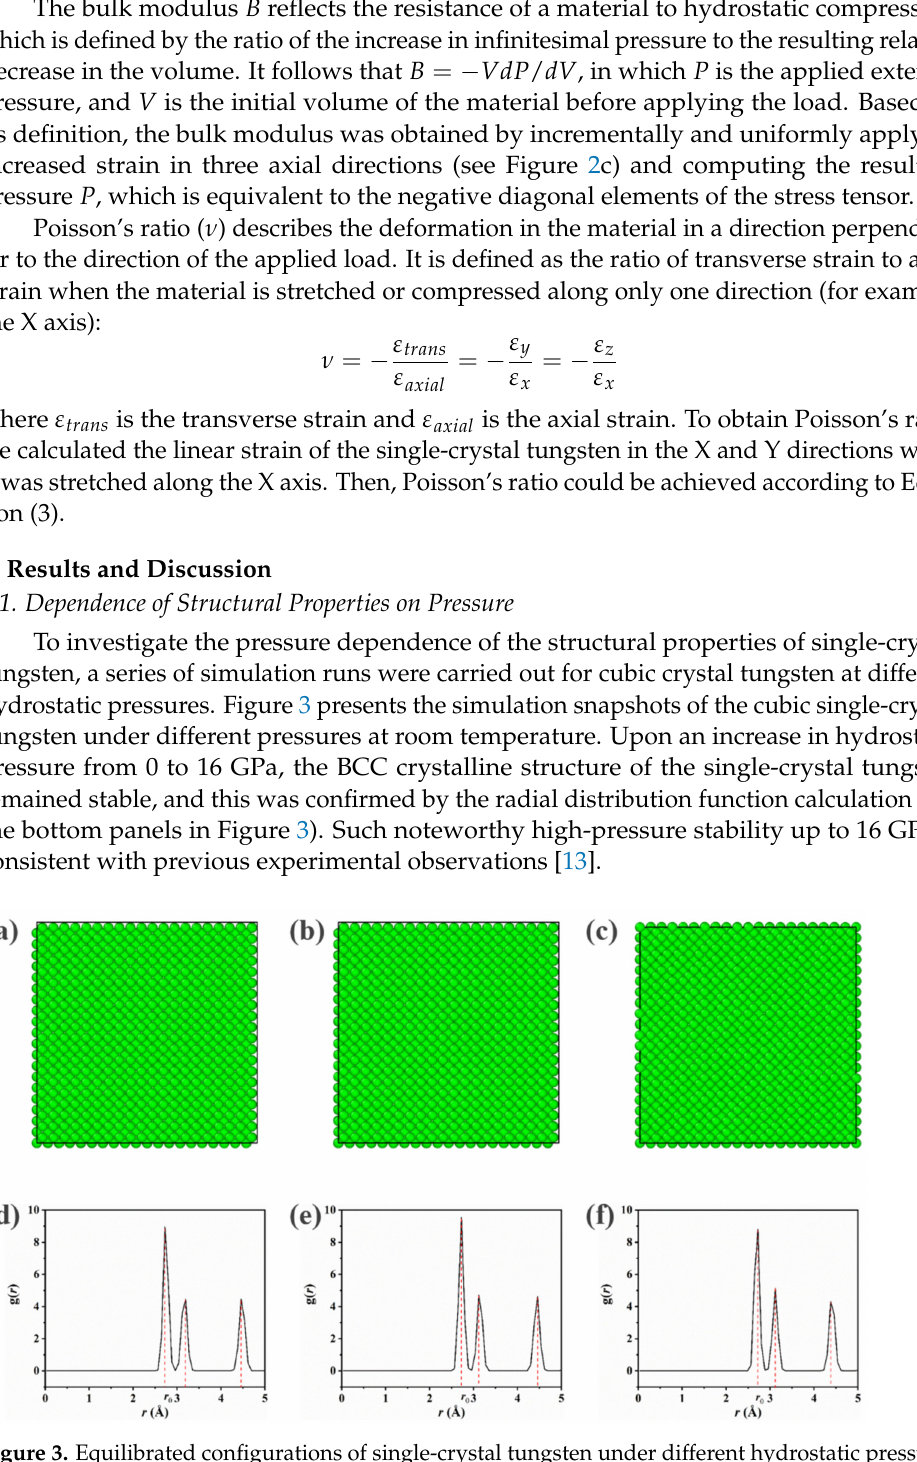
Figure 3. Equilibrated configurations of single-crystal tungsten under different hydrostatic pressures: ( a ) 0 GPa, ( b ) 8 GPa, and ( c ) 16 GPa. The corresponding radial distribution functions of single-crystal tungsten under different hydrostatic pressures: (d) 0 GPa, (e) 8 GPa, and (f) 16 GPa. Dotted lines in each panel represent the first three peaks of the radial distribution function. The first three peaks √ √ are located at the positions of r / r 0 = 1, 4/3, 8/3 ( r 0 is the radius of the first coordination shell in the radial distribution function calculation), which means that the crystal structures are perfect BCC